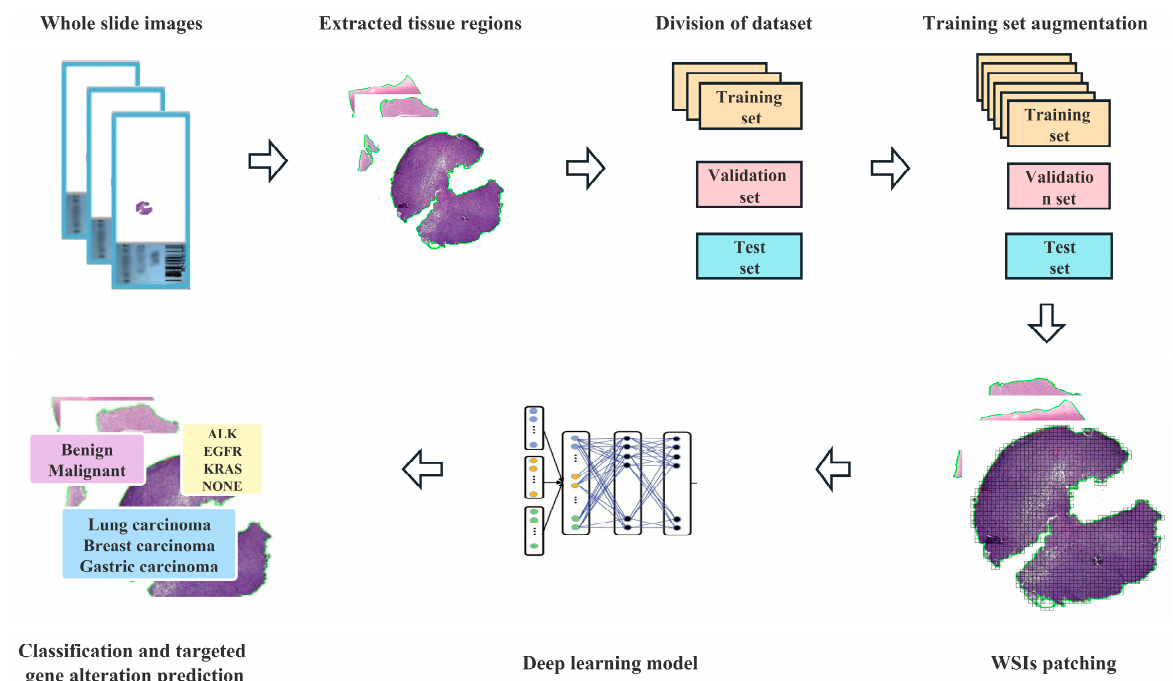
Figure 2. Flowchart of the deep learning framework presented in this study.